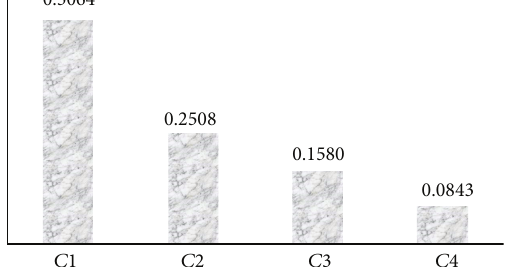
Figure 6: Graphical weights of available